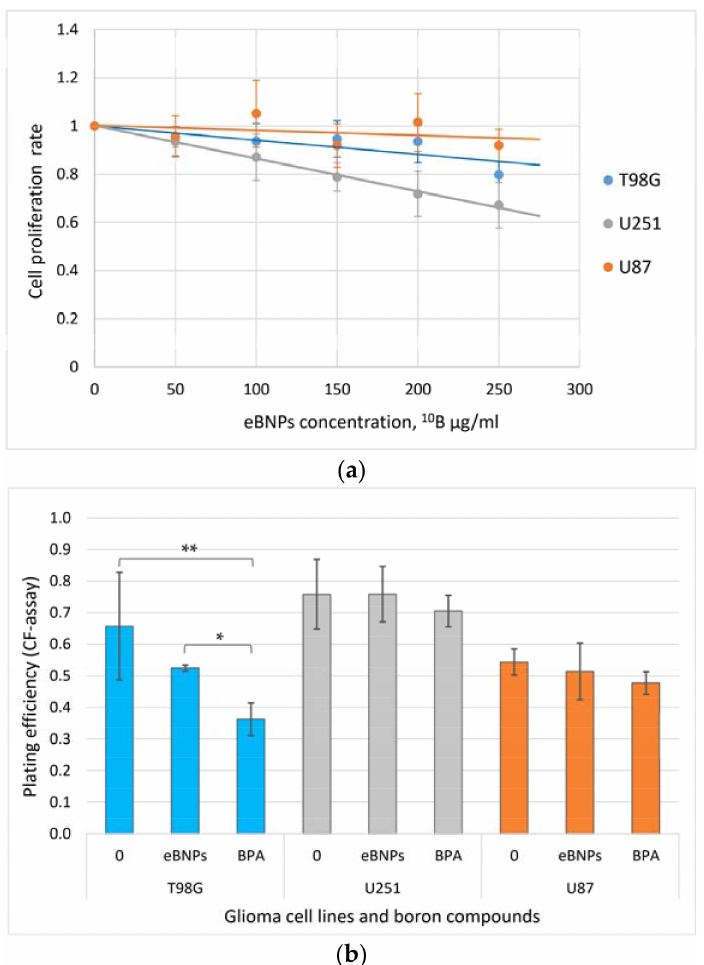
Figure 4. ( a ) Cancer cell survival after 24 h of incubation with nanoparticles evaluated by MTS assay ( b ). Cell plating efficiency 14 days after a 24-h incubation with 40 µ g of 10 B/mL of eBNPs or BPA, or without boron compounds analyzed by CF-assay; intergroup comparison by one-way ANOVA, * p = 0.003, ** p = 0.021, no significant difference in other groups ( p >